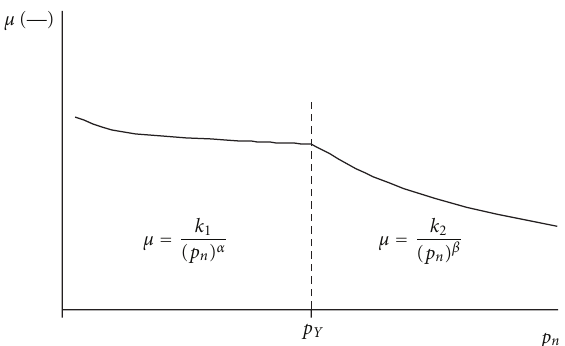
Figure 3: Coe ffi cient of dynamic friction μ versus nominal contact pressure p n according to (8).